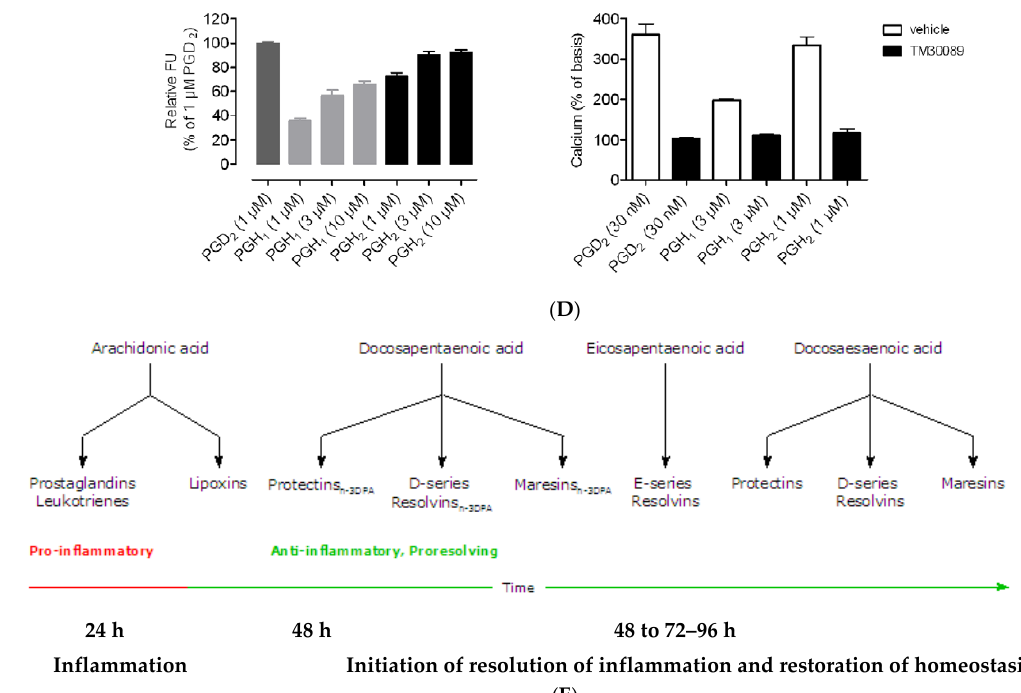
Figure 3. ( A ) Scheme showing the metabolism of AA and how pro-inflammatory LTA4 can be converted to anti-inflammatory LXA4. Similar conversion of pro-inflammatory PGs, TXs and LTs to anti-inflammatory resolvins, protectins and maresins may occur. ( B ) Scheme showing interaction(s) among BALs, cytokines, glucocorticoids, and inflammatory process. (-) Indicates inhibition of action or synthesis; (+) indicates increase in synthesis or action. sEH = soluble epoxide hydrolase; VNS = vagal nerve stimulation; ROS = reactive oxygen species. α-KG = alpha-ketoglutarate. Infections, surgery, and injury activate PLA2 leading to the release of AA and other unsaturated fatty acids from the cell membrane lipid pool. Simultaneously circulating leukocytes, macrophages and other immunocytes are activated that release IL-6 and TNF-α, which stimulate PLA2 leading to release of AA (and DGLA, EPA, DPA an DHA). COX-2 and LOX enzymes convert DGLA, AA, EPA and DHA to form their respective metabolites. To balance the action of pro-inflammatory cytokines, there will be release of anti-inflammatory cytokines IL-4 and IL-10. Pro-IL- β 1 released is converted to IL- β 1, a pro-inflammatory cytokine. IL- β 1 acts on cPLA2/sPLA2 to induce the release of second wave of AA from the cell membrane that can be converted to LXA4, an anti-inflammatory molecule. During the first 24 h of injury, infection, and surgery, iPLA2 is activated. AA and other PUFAs released due to the activation of iPLA2 are utilized mainly to form pro-inflammatory bioactive lipids. In contrast to this, 48–96 h after infection, injury, and surgery activation of cPLA2/sPLA2 occurs that induce the release of second wave of AA and other PUFAs (polyunsaturated fatty acids) that is used to form anti-inflammatory LXA4, PGD2 and PGJ2. This switchover from pro-inflammatory PGE2 and LTs to anti-inflammatory LXA4 is facilitated by PGE2. Once the local tissue and plasma concentrations of PGE2 reach the peak, it (PGE2) activates 5-LOX and 15-LOX enzymes to enhance the formation of LXA4 to initiate resolution of inflammation and enhance wound healing. If PGE2 concentrations fail to reach its peak levels, stimulation of 5- and 15-LOX fails to occur, and so inflammation persists. It is likely that once the PGE2 levels reach their peak, it stimulates cPLA2 and sPLA2 enzymes to induce second wave of AA release. EPA, DHA and DGLA may have actions like AA (not shown in the figure). EPA forms the precursor to 3 series PGs, TXs and 5 series LTs (that are less pro-inflammatory compared to 2 series PGs, TXs and 4 series LTs formed from AA but are nevertheless pro-inflammatory) and resolvins of E series that are anti-inflammatory. DHA forms precursor to resolvins, protectins and maresins all of which are potent anti-inflammatory molecules. DGLA is the precursor of PGE1, an anti-inflammatory molecule, that has actions like LXA4 (see Table 1 and Figure 3C). This figure is modified from reference [37]. ( C ) Scheme showing the metabolism of DGLA and their metabolites. PGH1 has pro-inflammatory actions but is less potent compared to PGH2 and PGE2. PGE1 is anti-inflammatory in nature. ( D ) PGH1 stimulates Ca 2+ mobilization in CRTH2 transfected and primary eosinophils. It is evident that PGH1 is less potent compared to PGH2 and so is less pro-inflammatory compared to PGH2 and PGE2. This data is taken from PLoS ONE 2012 , 7 , e33329, doi:10.1371/journal.pone.0033329. ( E ) Summary